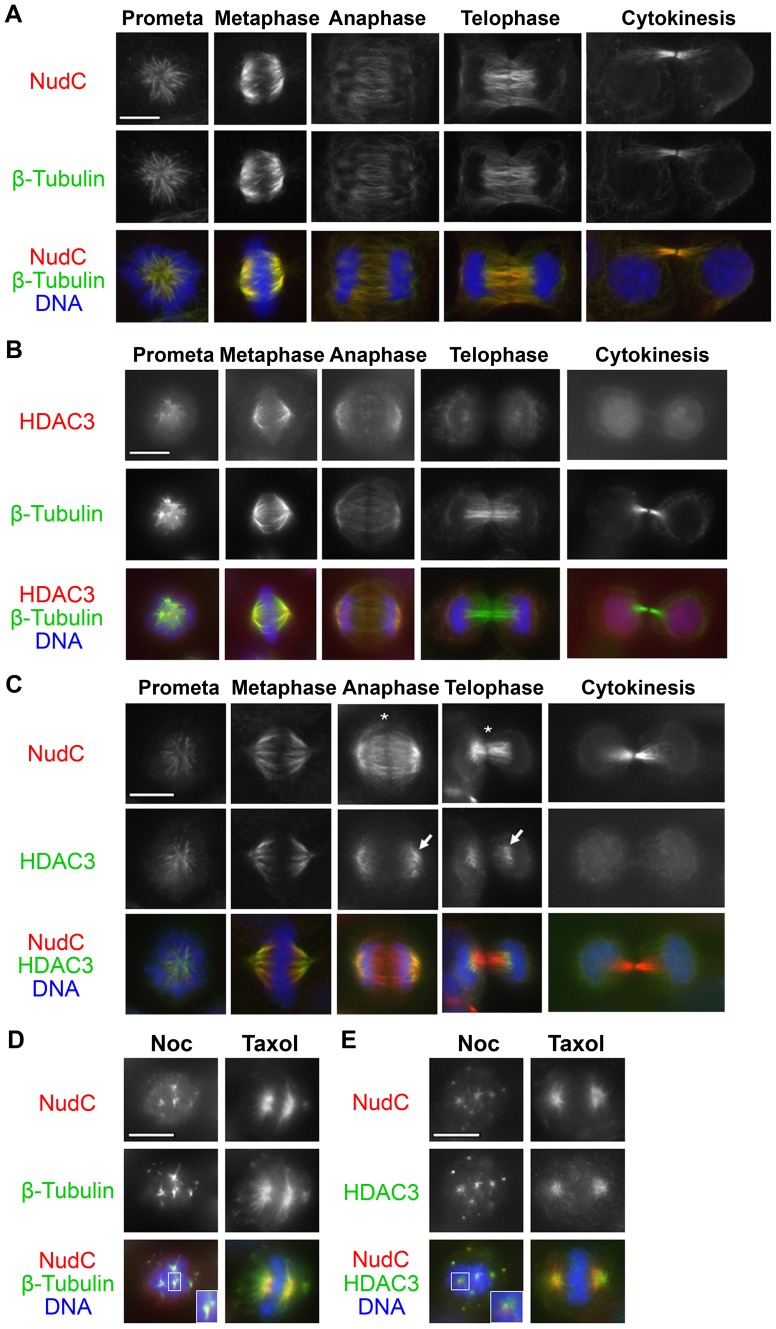
NudC and HDAC3 co-localize in early mitosis.HeLa cells were stained for NudC (A; red) or HDAC3 (B; red) and β-tubulin (A–B; green) then counterstained with DAPI (DNA; blue). (C) Cells were stained for NudC (red) and HDAC3 (green) then counterstained with DAPI (blue). In late mitosis, NudC translocates to the midzone and the midbody (asterisk), whereas HDAC3 remains on the mitotic spindle in anaphase and the minus-end (outer edges) of midzone microtubules in telophase (arrow). Cells were treated with Noc (D) or Taxol (E), stained for β-tubulin (D; green) or HDAC3 (E; green) and NudC (D–E; red), then counterstained with DAPI (DNA; blue). Images represent three independent experiments. All scale bars, 10 µm.